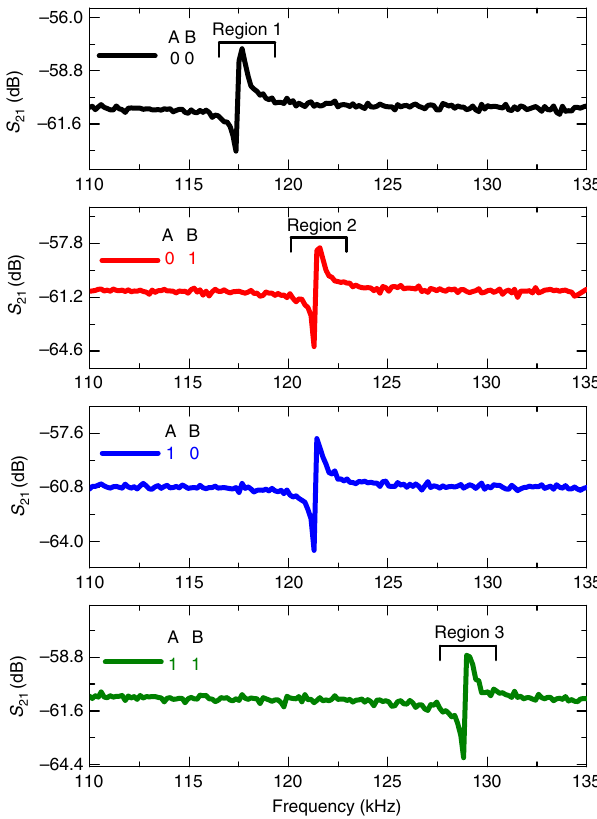
Figure 3 | Electrothermal frequency modulation. Frequency responses of the resonator for different logic input conditions, (0,0), (0,1), (1,0) and (1,1), shown in black, red, blue and green,